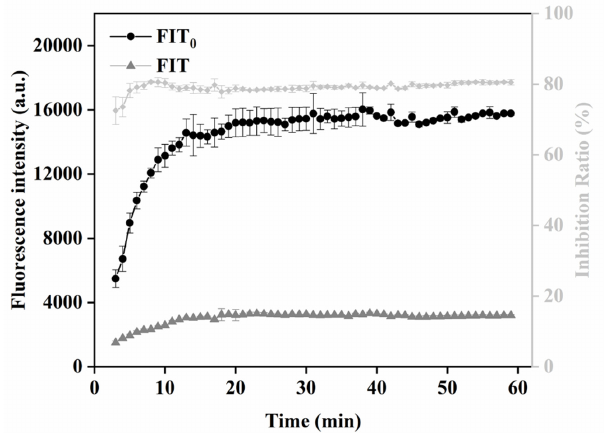
Figure 7. Optimization detection conditions of QBs-LFIA. Immunoreaction dynamic of FIT of negative (0 ng/mL) and positive (5 ng/mL) samples on the fluorescence intensity of T line and inhibition ratios.